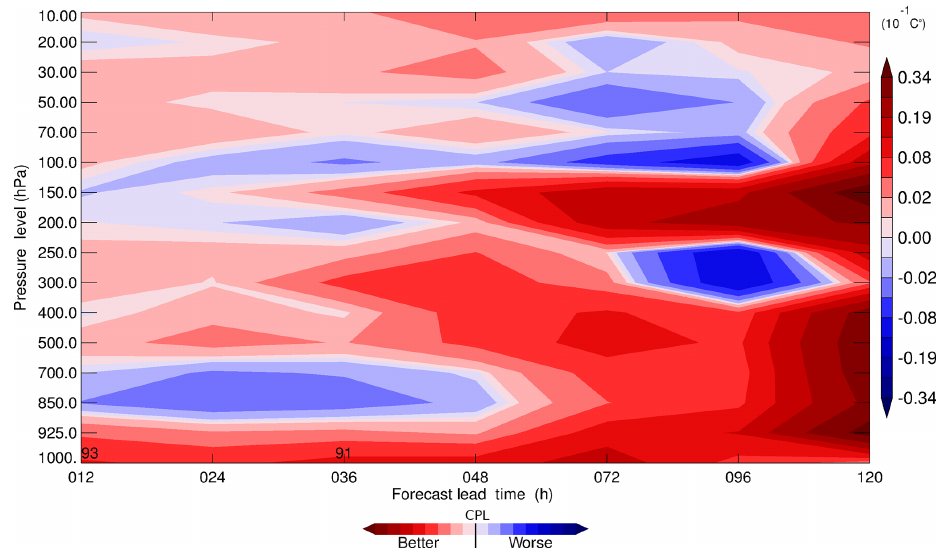
Figure 6. Difference in the standard deviation of the air temperature ( ◦ C) against the mean analysis as a function of forecast lead time. The statistics are computed for CPL and UNCPL in the northern extratropics region between 20 and 60 ◦ N. Positive values (red) mean that the standard deviation produced by CPL is smaller, whereas negative values (blue) mean the converse. Numbers show the areas where the difference between CPL and UNCPL is statistically significant with a confidence level above 90%.